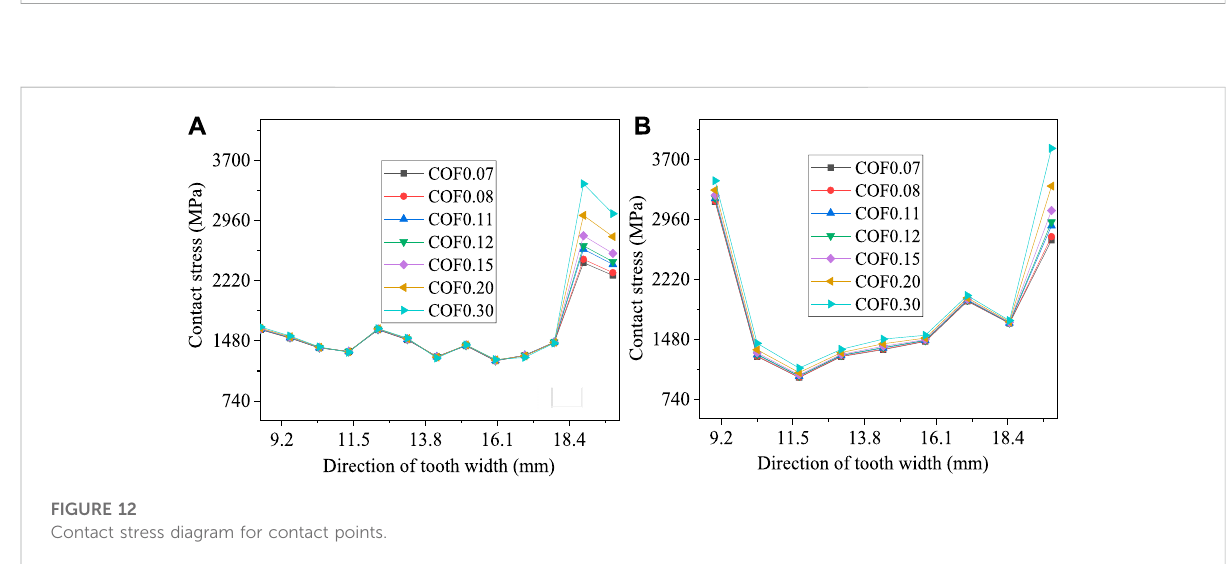
FIGURE 12 Contact stress diagram for contact